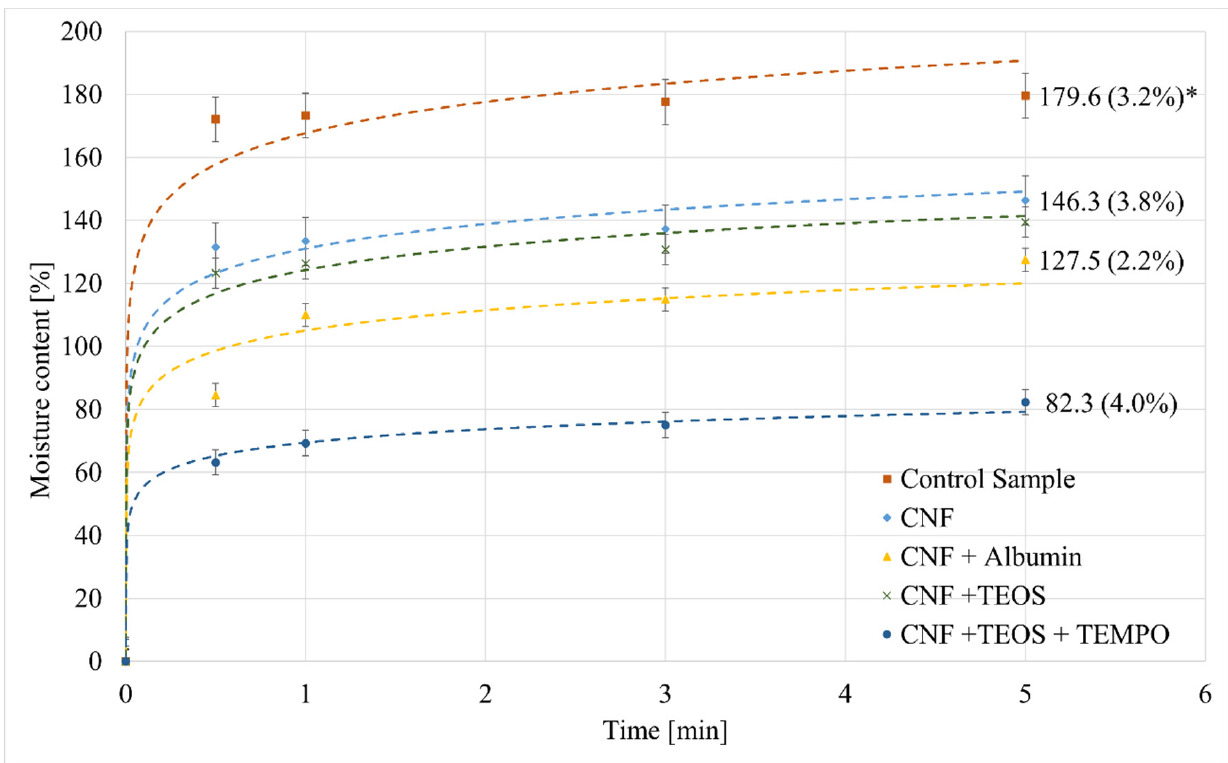
Figure 6. Water absorption (%) of tested CNF samples. * The relative standard deviation (RSD) (%) values are shown in parentheses.